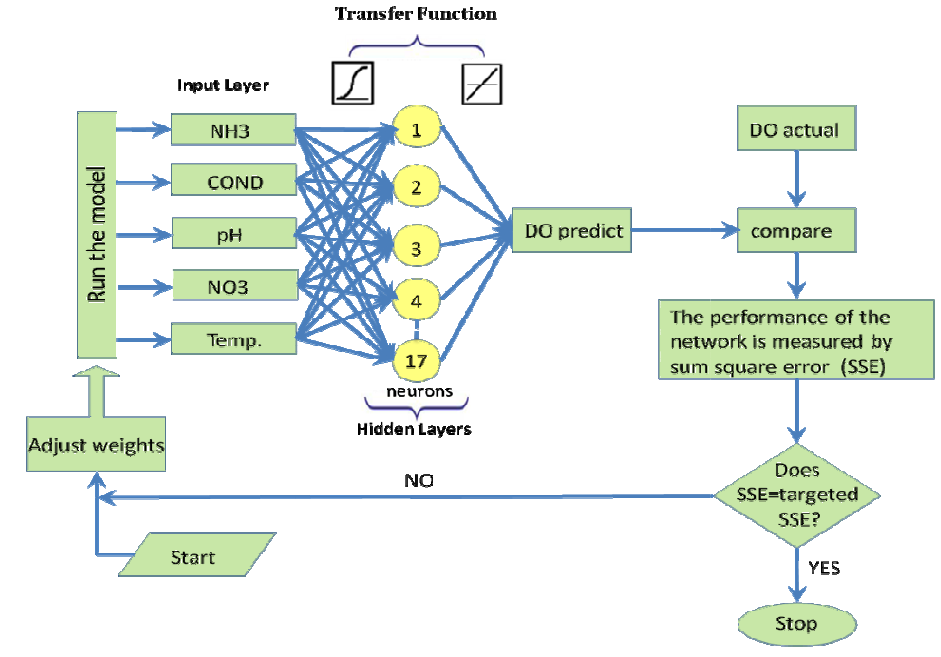
Fig. 4: An optimal architecture of architecture of ANN, together with a flowchart of the algorithm’s